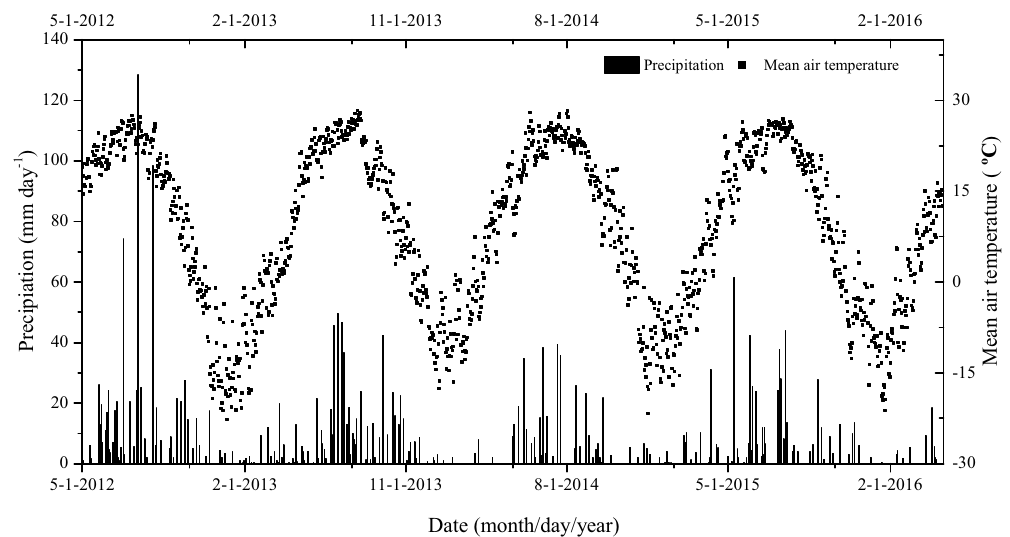
Figure 1. Precipitation and daily mean air temperature during four annual cycles from May 2012 to April 2016 in the experimental field.